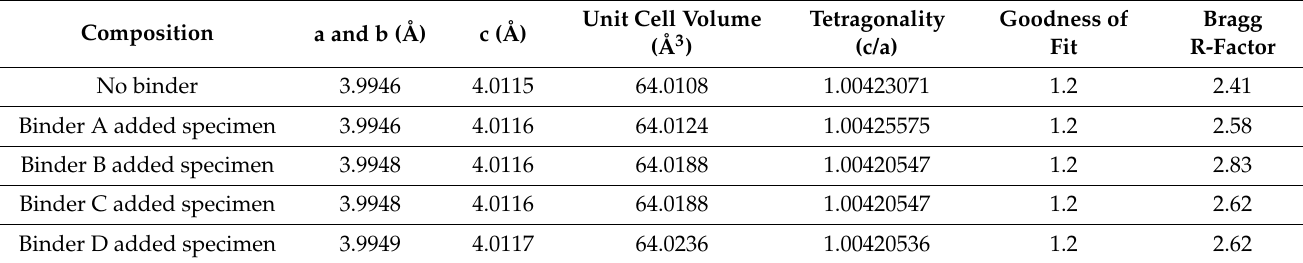
Table 4. Refined structural parameters of the 0.1 wt.% Dy 2 O 3 -doped 0.98BaTiO 3 -0.02(Ba 0.5 Ca 0.5 )SiO 3 specimens sintered at 1320 ◦ C for 1 h with different binders.